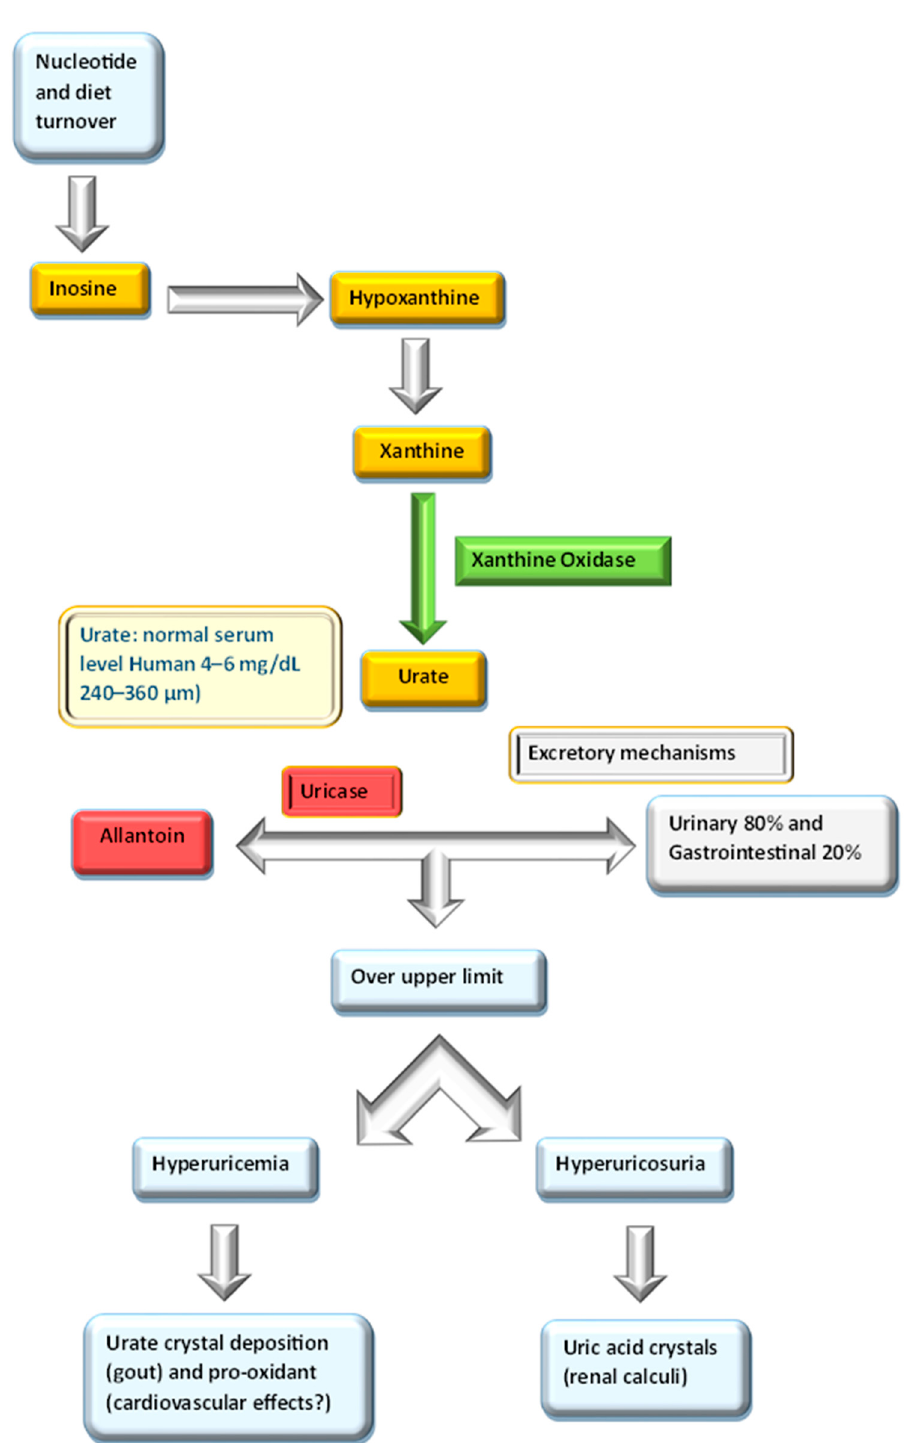
Figure 2. Pathways of urate homeostasis.